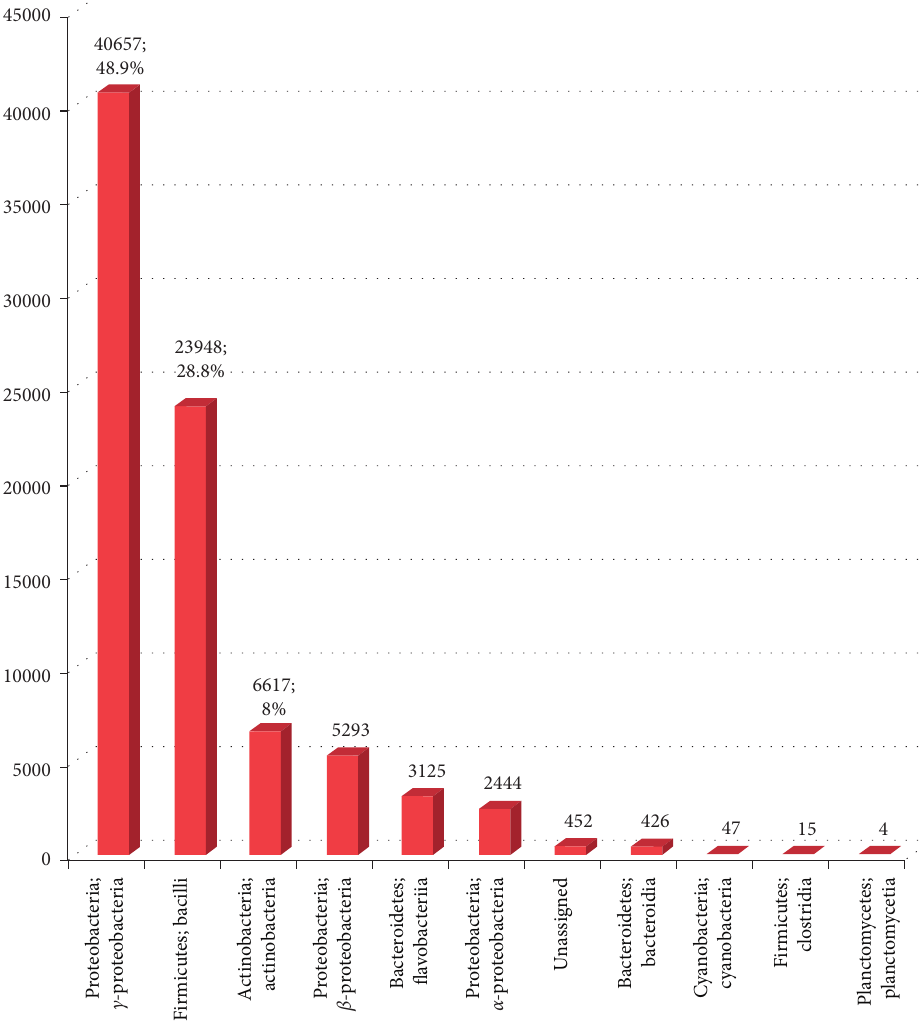
Figure 2: Relative frequency of bacterial class level in A. nigrocincta